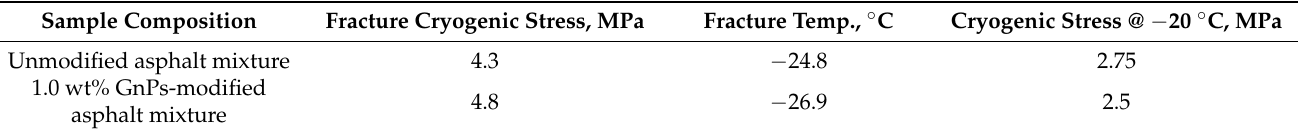
Table 3. TSRST results for modified and unmodified asphalt